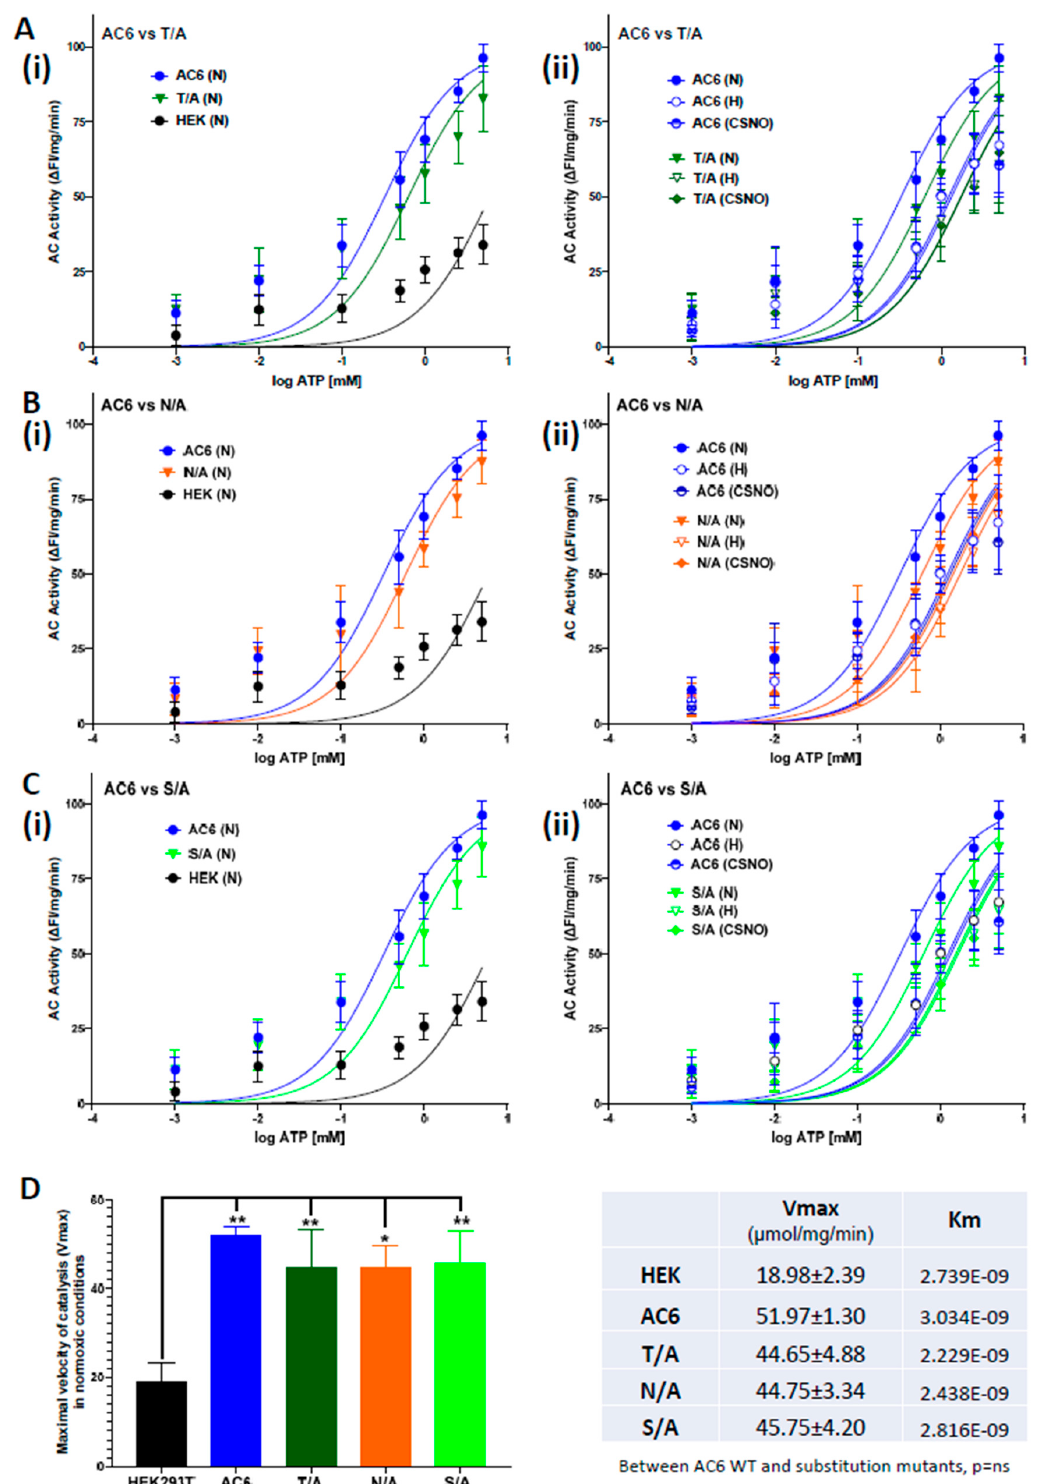
Figure 5. ATP dose-dependent catalytic activity in AC6 Forskolin binding site mutants. AC activity is measured as a loss of luminescence (FI) of terbium norfloxacin when unbound from ATP (substrate) and bound to inorganic phosphate donated by the action of AC. AC activity vs ATP substrate concentration (10 − 6 –10 − 2 M) in ( A ) AC6 WT vs. mutant T/A; ( B ) AC6 WT vs. mutant N/A; and ( C ) AC6 WT vs. S/A was ( i ) quantified in normoxia (N, 21% O 2 , 5% CO 2 ), and ( ii ) compared with hypoxia (H, 10% O 2